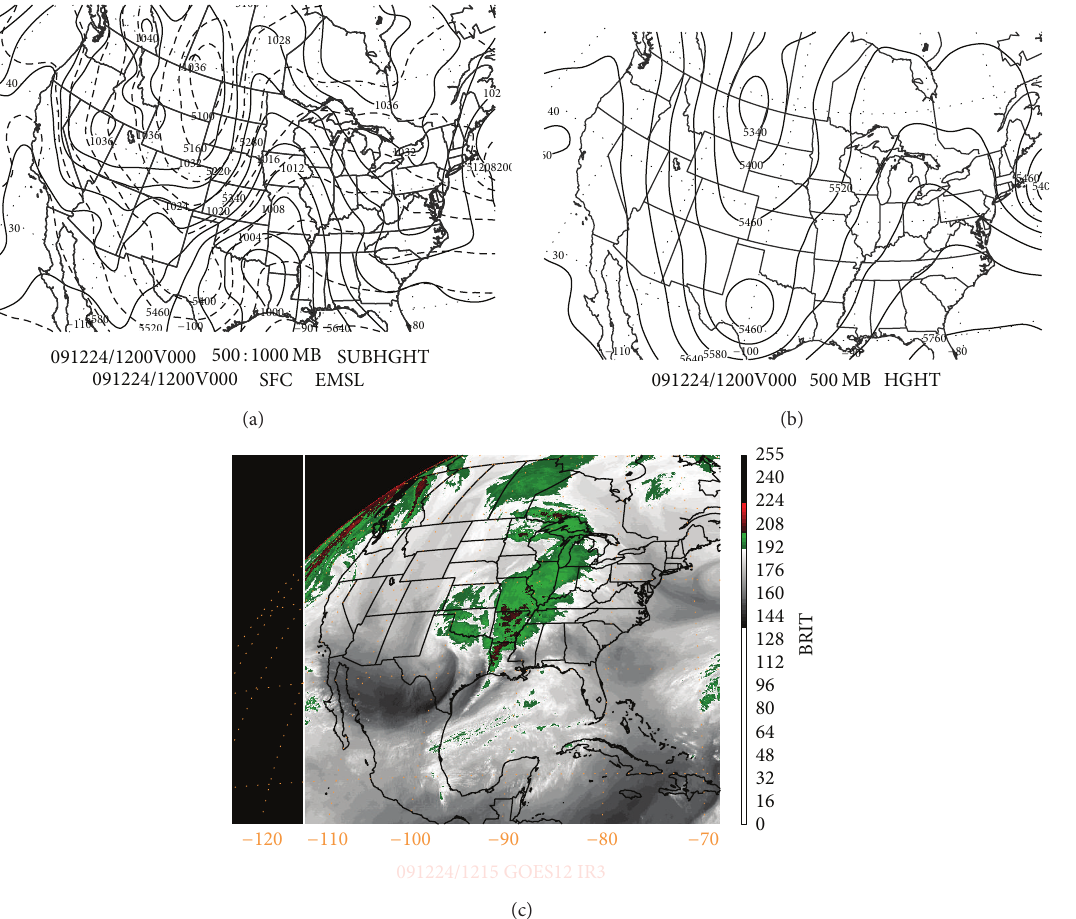
Figure 1: Maps and analyses for 1200 UTC 24 December 2009, where (a) is the mean sea level pressure (solid, every 4 hPa) and 1000–500-hPa geopotential thickness (dashed, every 60 gpm) from NAM Eta initialization, (b) the 500 hPa geopotential heights (solid, every 60 gpm), and (c) the GOES-12 water vapor image at 1215